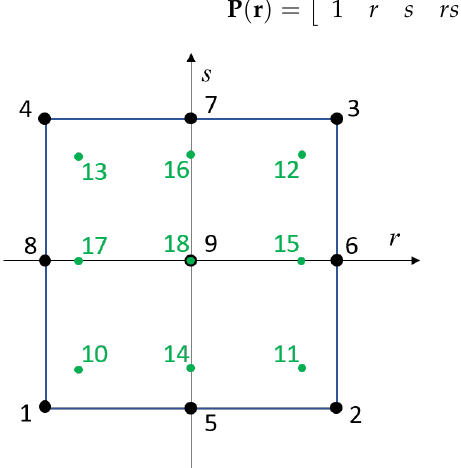
Figure 3. The nine-noded quadrilateral element in the local curvilinear coordinate system with 3 × 3 Gaussian quadrature